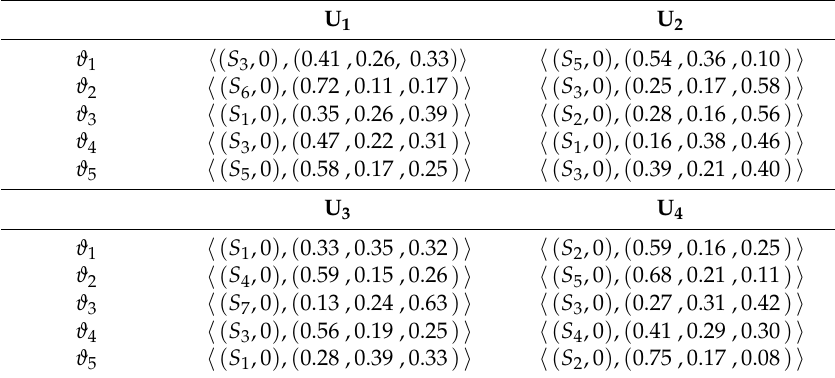
Table 1. Picture 2-tuple linguistic evaluation information by q 1 .